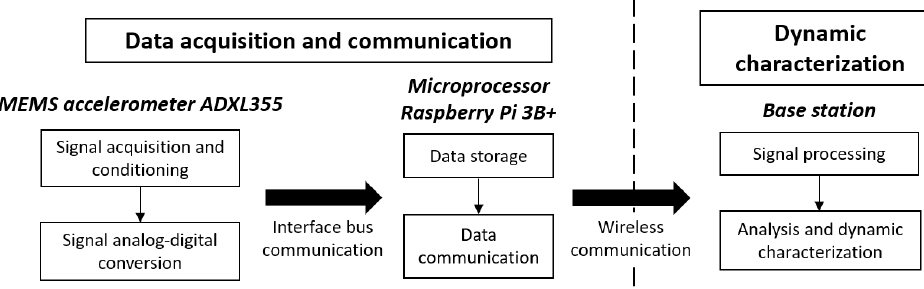
Figure 3. Function block diagram of the low-cost WSN monitoring